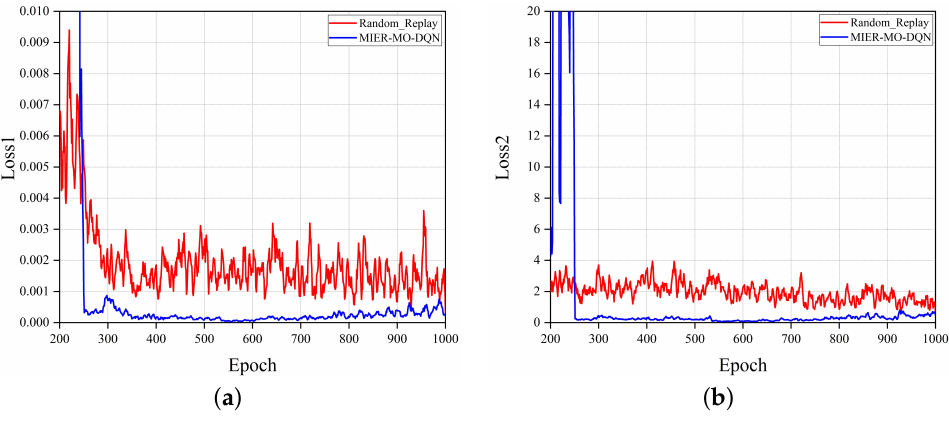
Figure 11. Change in ( a ) Loss1, ( b )